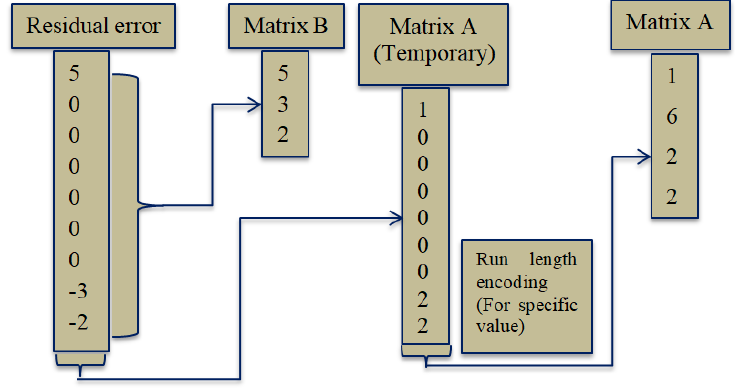
Figure 2. Modified J-bit encoding process.